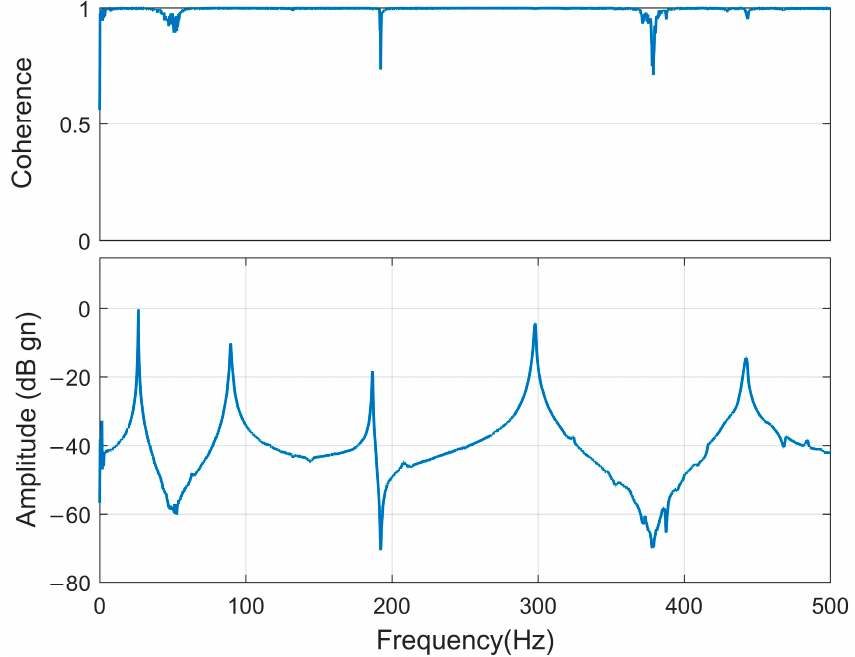
Figure 6. Coherence function and frequency–amplitude graph of the free–free beam with unequal tip masses. Table 4. The first five natural frequencies of the beam-end mass system.